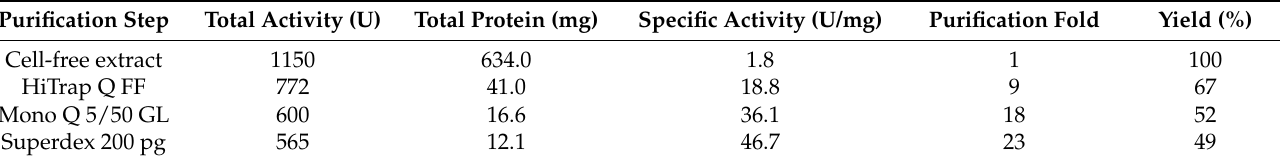
Table 6. Purification of recombinant Paracoccus sp. 32d β - D